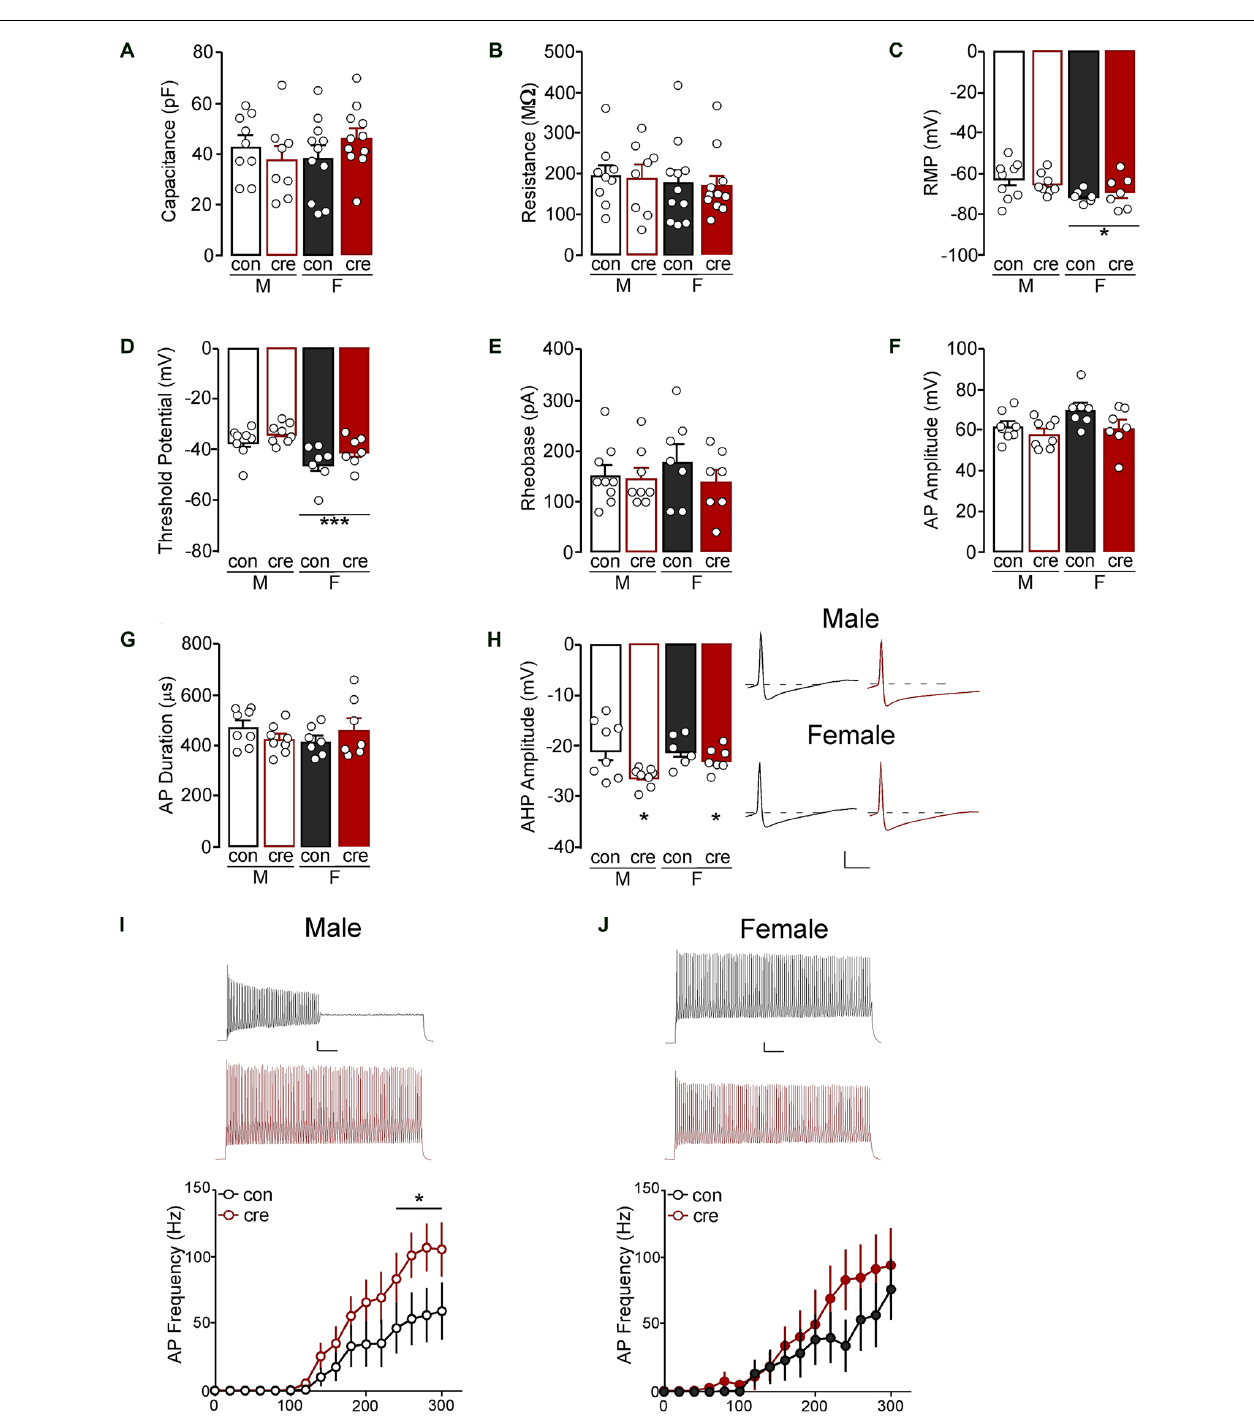
FIGURE 6 | (A) The capacitance and (B) resistance of PVI neurons were similar for all groups. (C) The resting membrane potential (RMP) of PVI from females, regardless of condition, were more negative than those from males (* p < 0.05). (D) The threshold potential before firing an action potential was also more negative in PVI from females compared to males (*** p = 0.001). (E) The current required to evoke an action potential was similar for all groups. (F) The action potential (AP) amplitude and (G) duration was similar for all groups. (H) Afterhyperpolarization (AHP) amplitude for the first action potential from cre-positive PVI, regardless of sex, was more negative compare to PVI from cre-negative mice (* p < 0.05; scale: 20 mV/5 ms). (I) The number of action potentials fired at 240–300 pA was higher in PVI from cre-positive male mice compared to control male mice (* p < 0.05; scale 10 mV/100 ms, traces at 300 pA). (J) PVI had similar action potential frequency in cre-positive and control female mice (scale 10 mV/100 ms, traces at 300